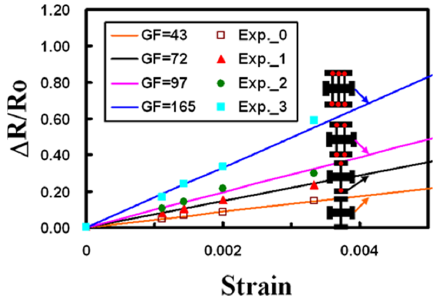
Figure 5. The relation between Δ R / R 0 and applied ε for 0, 1, 2, and 3 HR paths of the flexible PR strain sensors. For the PR strain sensor patterns, a pair of red circles denote the generation of one HR path. The gauge factor (GF) values of 43, 72, 97, and 165 extracted from the slope of the solid lines represent 0, 1, 2, and 3 HR paths, respectively. Exp._0, Exp._1, Exp._2, and Exp._3 denote the experimental data of 0, 1, 2, and 3 HR paths, respectively.